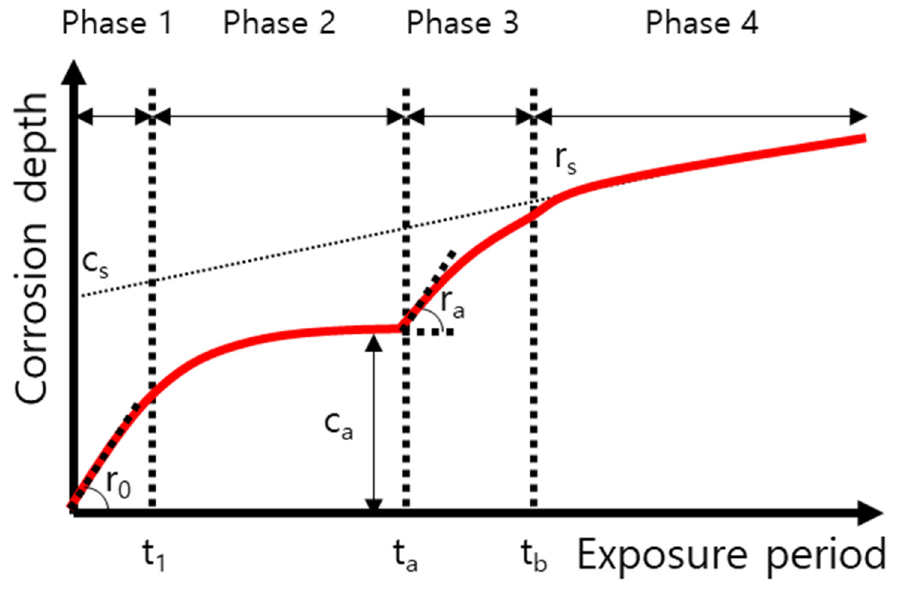
Figure 2. General and pitting corrosion model curves. Table 1. Melchers general and pitting corrosion model parameters [19,23,27,28].